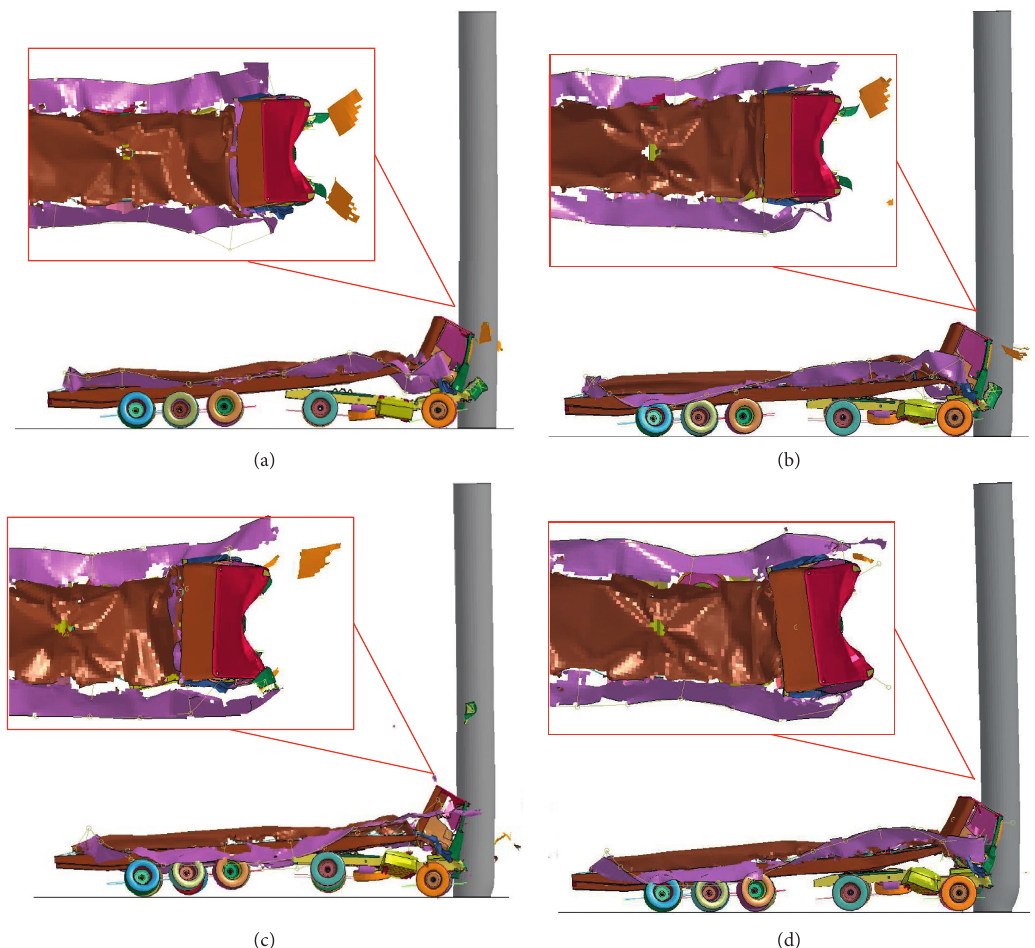
Figure 11: Shape of truck and bridge column depending on impact speed (column type IV). (a) 100km/h. (b) 110 km/h. (c) 120 km/h. (d) 130km/h.